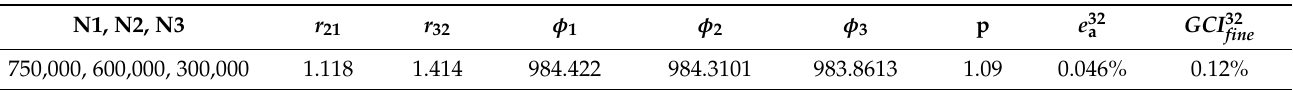
Table 5. Sample calculation of discretization